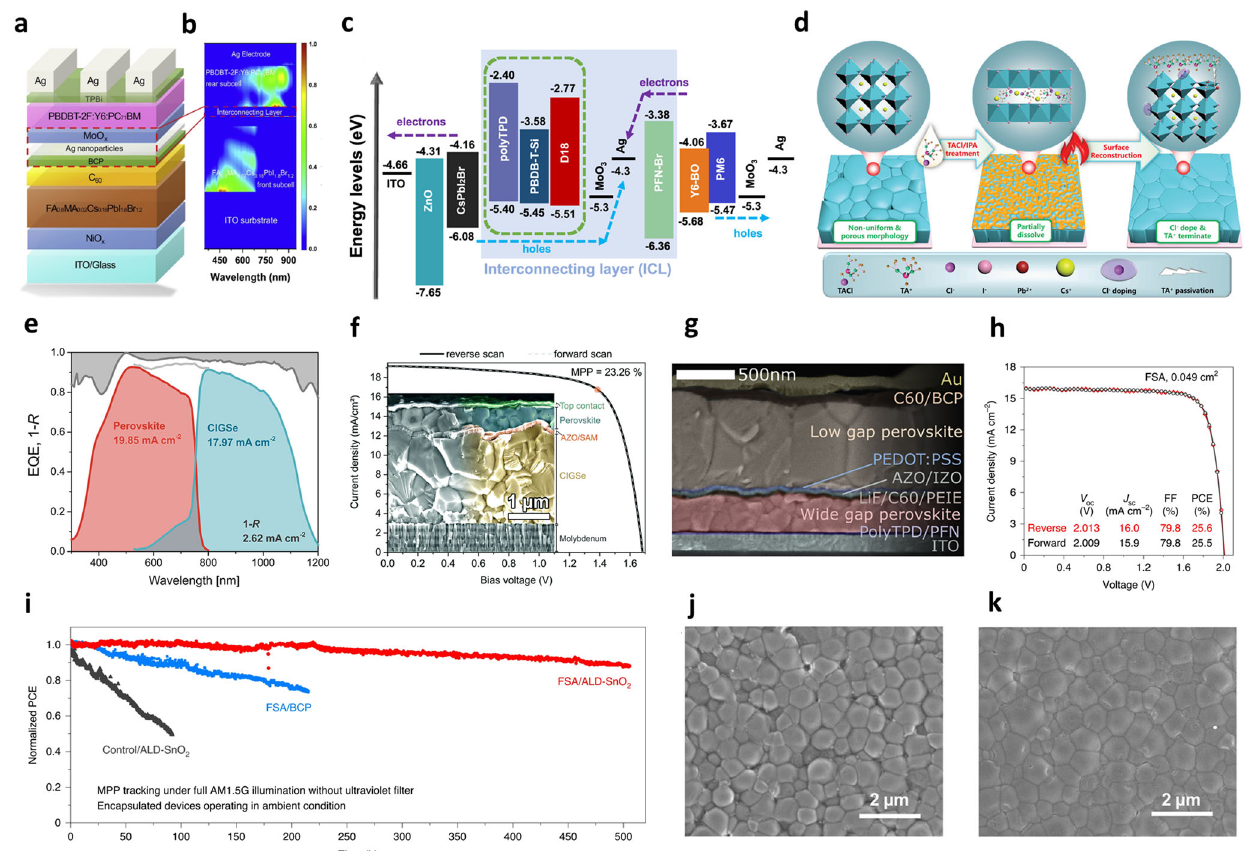
Fig. 3 Device engineering of perovskite-based tandem solar cells. a Tandem cell structure highlighting the interconnection layer (ICL) design. b Simulated distribution of photon absorption in tandem cells using the transfer matrix method. a , b adapted with permission from ref. 18 , Copyright 2020 Elsevier Inc. c Energy-level diagram of an inorganic perovskite/organic tandem solar cell (TSCs). c adapted with permission from ref. 10 , Copyright 2021 American Chemical Society. d Schematic illustration of the trimethylammonium chloride (TACl) and IPA synergistically induced surface reconstruction (SR) subcells and the total re fl ection ® spectra depicted as 1-R. Perovskite, CIGSe, and 1-R spectra are denoted with red, blue, and gray lines and areas. Integrated photocurrents and re fl ection losses from the EQE and 1-R spectra values are also shown. e adapted with permission from ref. 30 , Copyright 2019 American Chemical Society. f J – V curve of a monolithic CIGSe/perovskite-tandem solar cell (active area of 1.034 cm 2 ), with MeO-2PACz2PACz as a hole- selective contact (HSC) that is used to conformally cover the rough CIGSe bottom cell. The orange circle indicates the MPP at a PCE of 23.3% PCE. Inset: SEM image of the cross-section of a representative tandem device. f adapted with permission from ref. 31 , Copyright 2019 Royal Society of Chemistry. g Cross-sectional scanning electron micrograph of an all-perovskite tandem. g adapted with permission from ref. 35 , Copyright 2019 Elsevier Inc. h J – V curves of the current champion all-perovskite-tandem solar cells (all-PTSCs) fabricated with a formamidine sul fi nic acid additive scanned in the reverse and forward directions. i Continuous MPP tracking of encapsulated all-PTSCs over a period of 500 h under 1 Sun (100 mW cm − 2 ) light illumination without an ultraviolet fi lter in ambient air with a humidity of 30 – 50%. ( h , i ) adapted with permission from ref. 36 Copyright 2020 Springer Nature. j , k SEM images of perovskite fi lms prepared ( j ) without and ( k ) with 7% of a GuaSCN additive. j , k adapted with permission from ref. 37 , Copyright 2019 American Association for the Advancement of